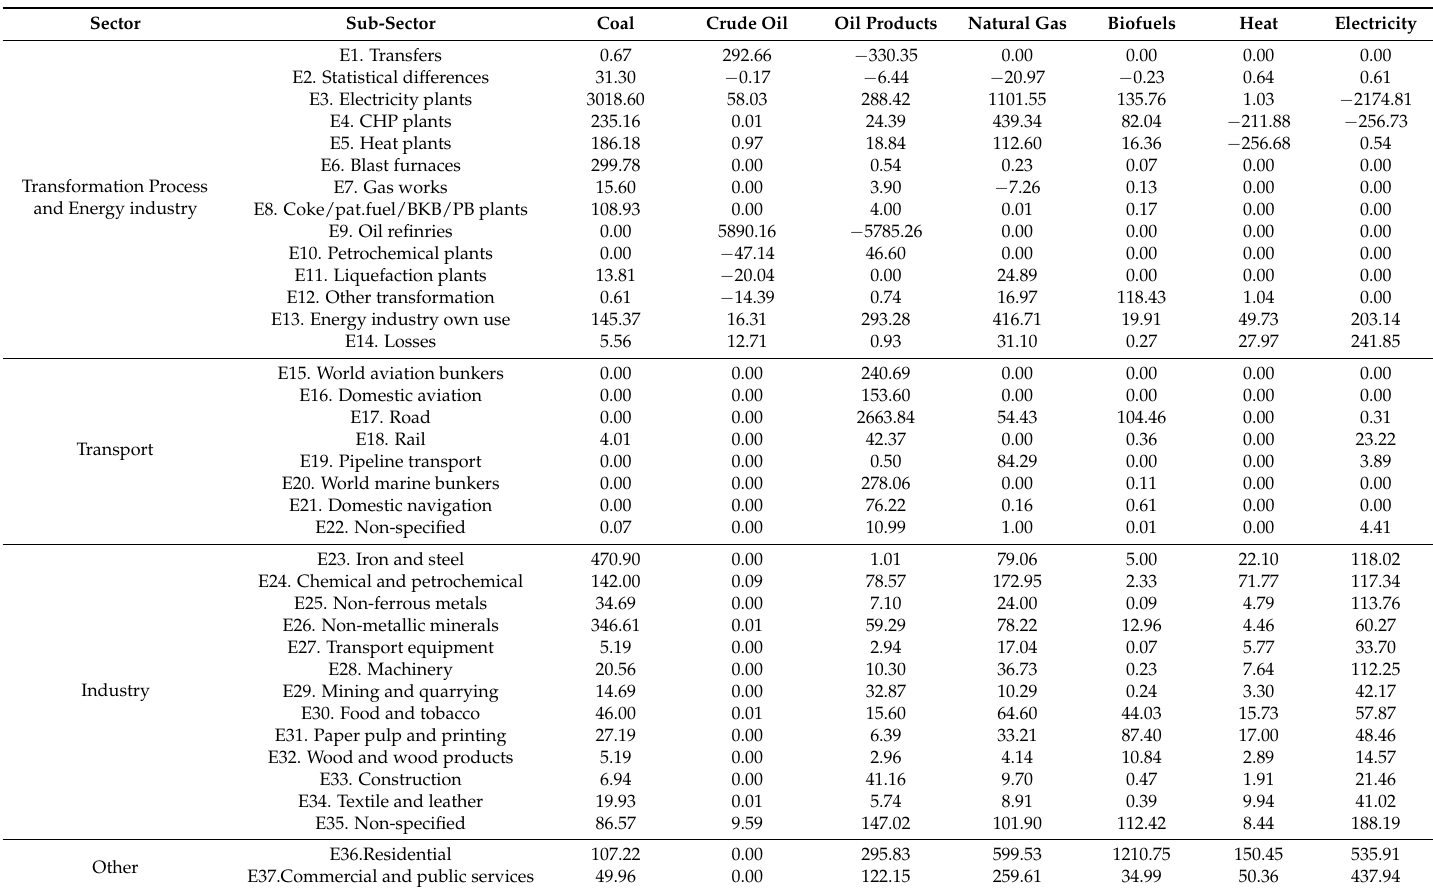
Table A1. Energy consumption by various sectors from